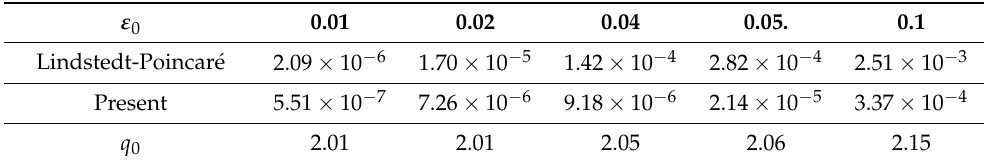
Table 1. The maximum errors obtained by the Lindstedt-Poincar é method and the present method for the analytic solutions of Example 1 with different ε 0